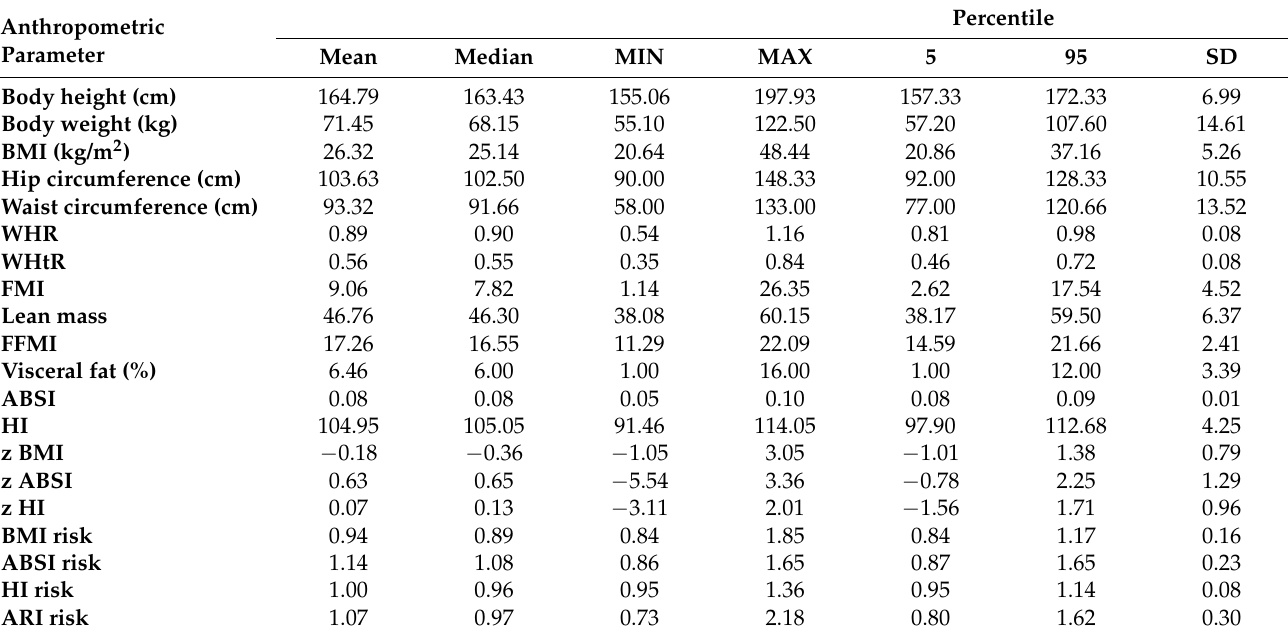
Table 1. Descriptive characteristic of the